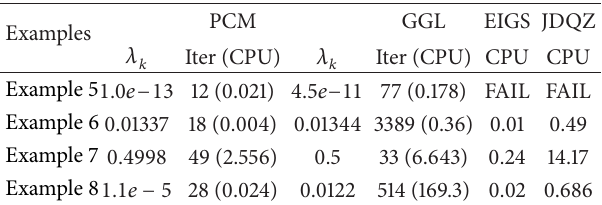
Table 1: Comparison with different methods.